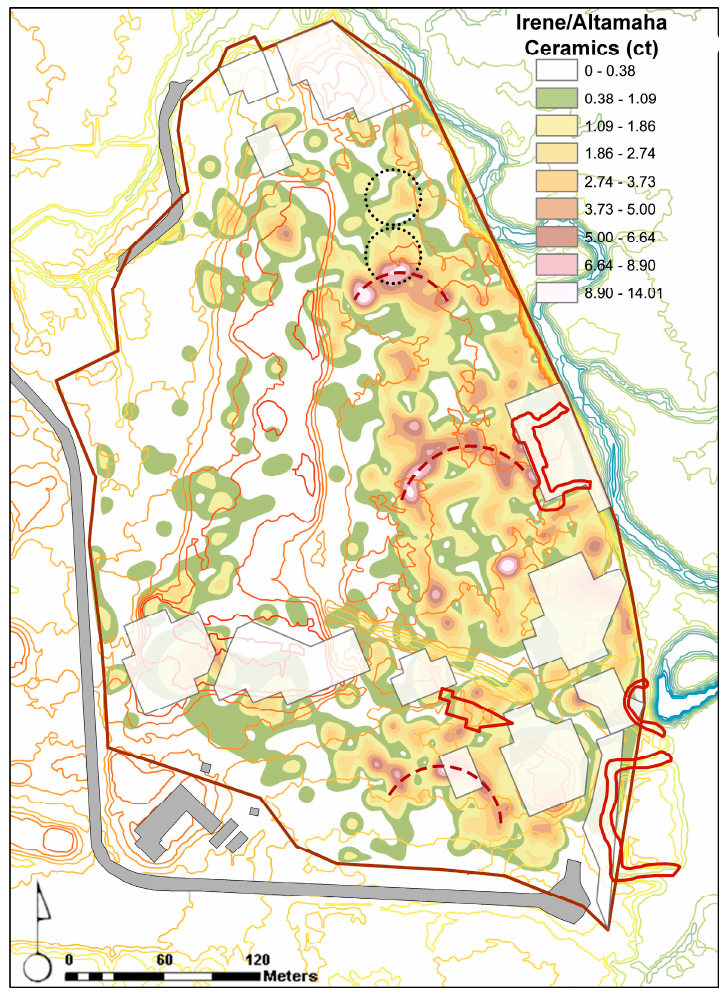
Figure 8. The distribution of Irene and Altamaha period ceramics recorded through a shovel test survey. Two potential council houses are identified by black dotted circles. Areas whited-out were not shovel tested. Dashed red lines indicate arcs mentioned in text. Contour spacing is 1 m. Contours are based on the LiDAR dataset and use the NAD 1983 and NAV 1988 horizontal and vertical datum, respectively.